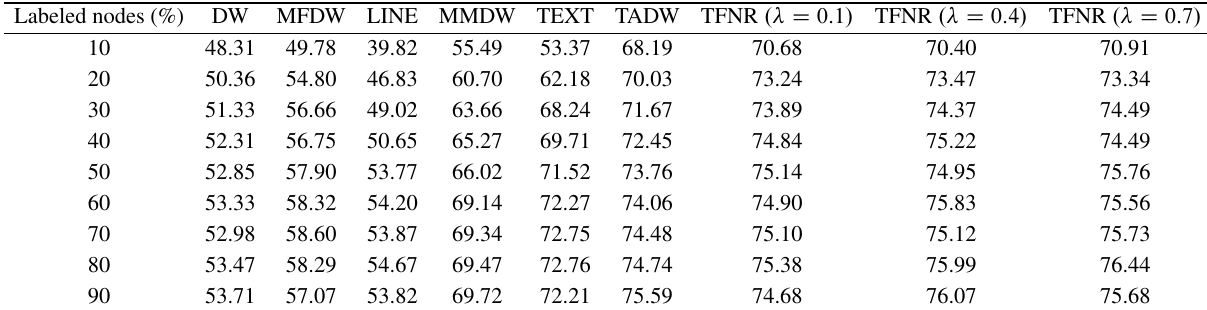
Table 3 Accuracy of vertex classification on Citeseer.